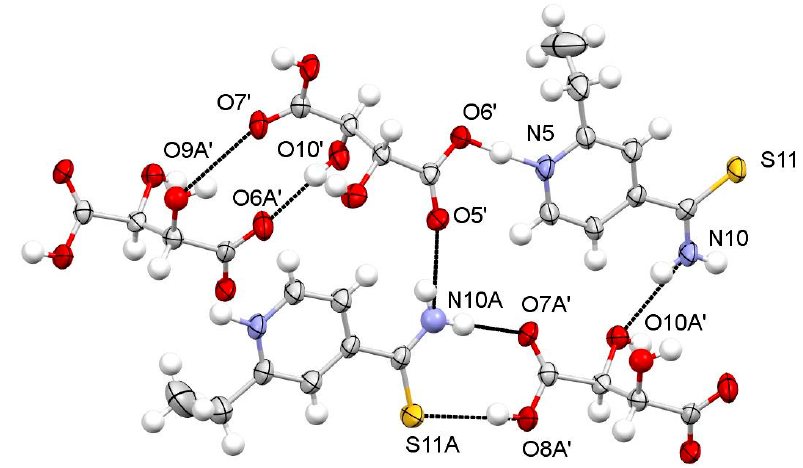
Figure 6. HB interactions between chains in ETN·TAR.